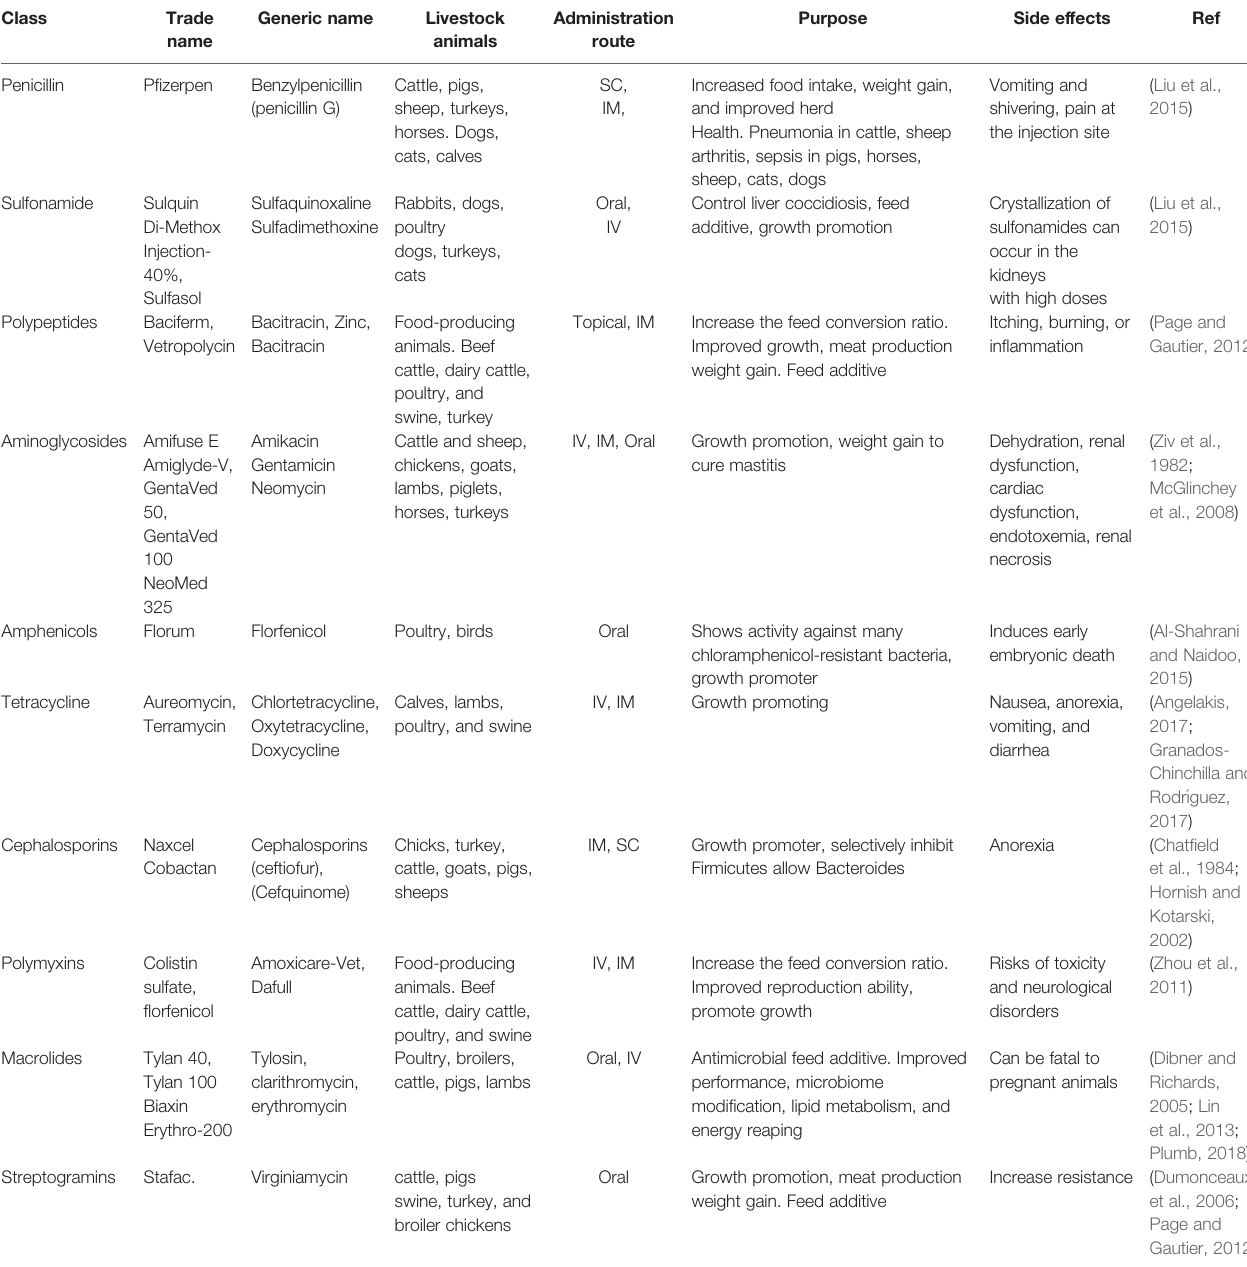
TABLE 1 | The global impact of antibiotic treatment on food-producing